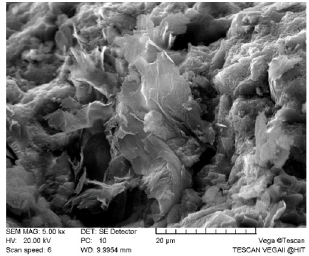
Figure 1. Scanning electron microscope (SEM) images of graphene nanoplatelets (GNP).